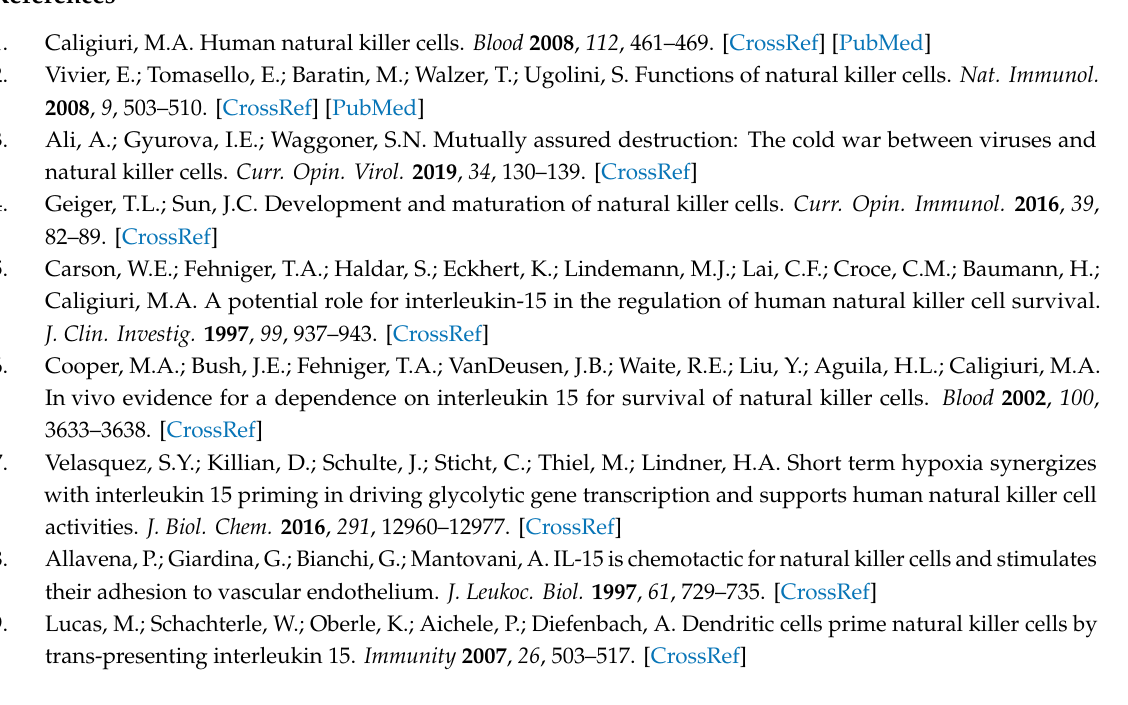
Figure S1: Glycolytic parameters in human NK cells primed with IL-15 under chemical hypoxia. Figure S2: Flow cytometric gating strategy for IFN γ quantitation. Figure S3: Flow cytometric gating strategy for the quantitation of multiple markers. Figure S4: Glycolytic parameters in untreated and IL-15 primed human NK cells. Figure S5: E ff ect of DMOG on glycolytic parameters in IL-15 / IL-12 / IL-18 treated human NK cells. Figure S6: Glucose deprivation has little e ff ect on stable oxygen consumption in human NK cells. Figure S7: Early cytokine responses in human NK cells to IL-12 / IL-18 after long-term IL-15 exposure do not require glucose. Figure S8: DMOG is detrimental to IFN γ production and CC chemokine release by IL-15 primed human NK cells in response to IL-12 / IL-18. Supplemental